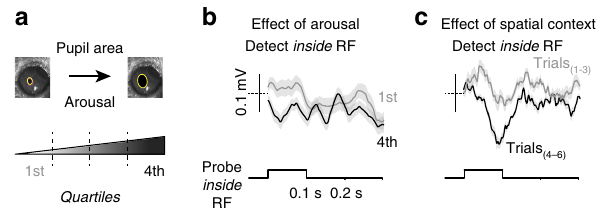
Fig. 4 Effect of arousal is not comparable to that of spatial context. a Pre- stimulus pupil area preceding each trial of correct detection split into quartiles. Larger pupil area indicates greater arousal. b LFP responses to probes presented inside the receptive fi eld (RF), on detect inside RF trials. Gray indicates population LFP responses on trials in 1st quartile of pupil area (low arousal), black indicates responses on trials in 4th quartile of pupil area (high arousal). Mean ± s.e.m. c LFP probe responses during